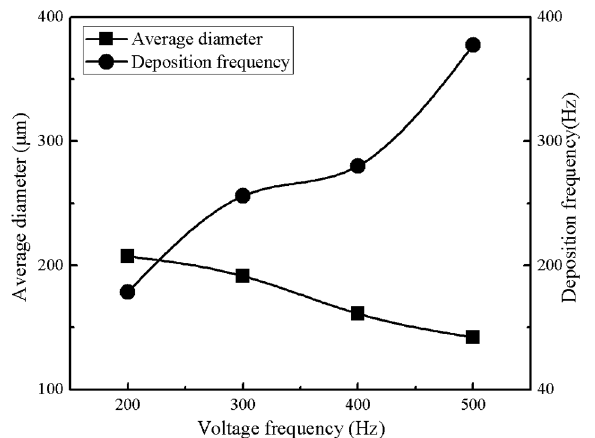
Figure 9. Direct-write micro-droplets on a silicon substrate under different voltage frequency: ( a ) 200; ( b ) 300; ( c ) 400; and ( d ) 500 Hz. Voltage amplitude, solution supply rate, nozzle inner diameter, distance between nozzle and collector, and platform moving speed are 1807 V, 60 μL/h, 60 μm, 3 mm, and 50 mm/s, respectively.